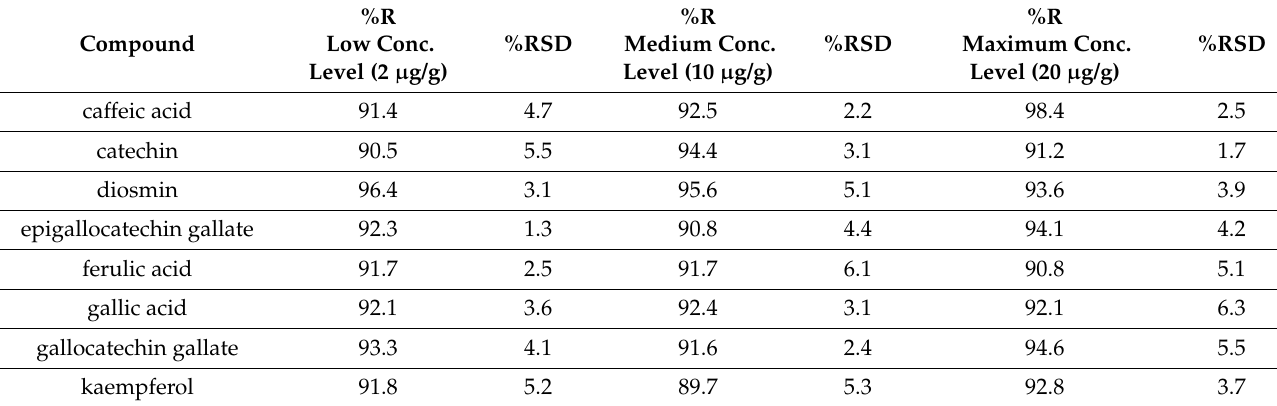
Table 2. %Recoveries (%R, n = 6) for the evaluation of